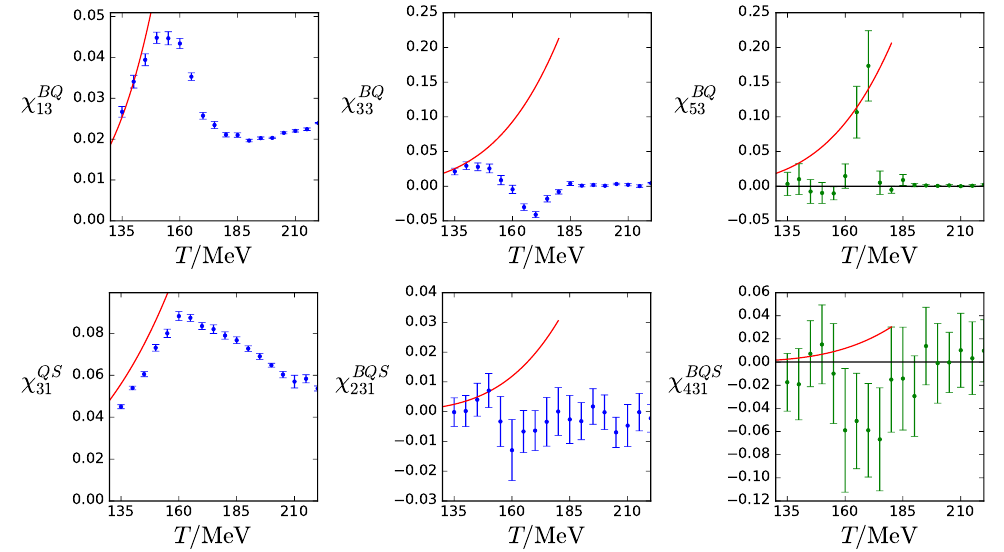
Figure 13 . Results containing three electric charge derivatives on the various correlators on our 48 3 (cid:2) 12 lattice as functions of the temperature. Green data points denote our estimates for the high orders, these were (cid:12)tted using a prior distribution. The red curves are the HRG model results. Charge correlators without baryon derivative (here (cid:31) QS discretization errors.